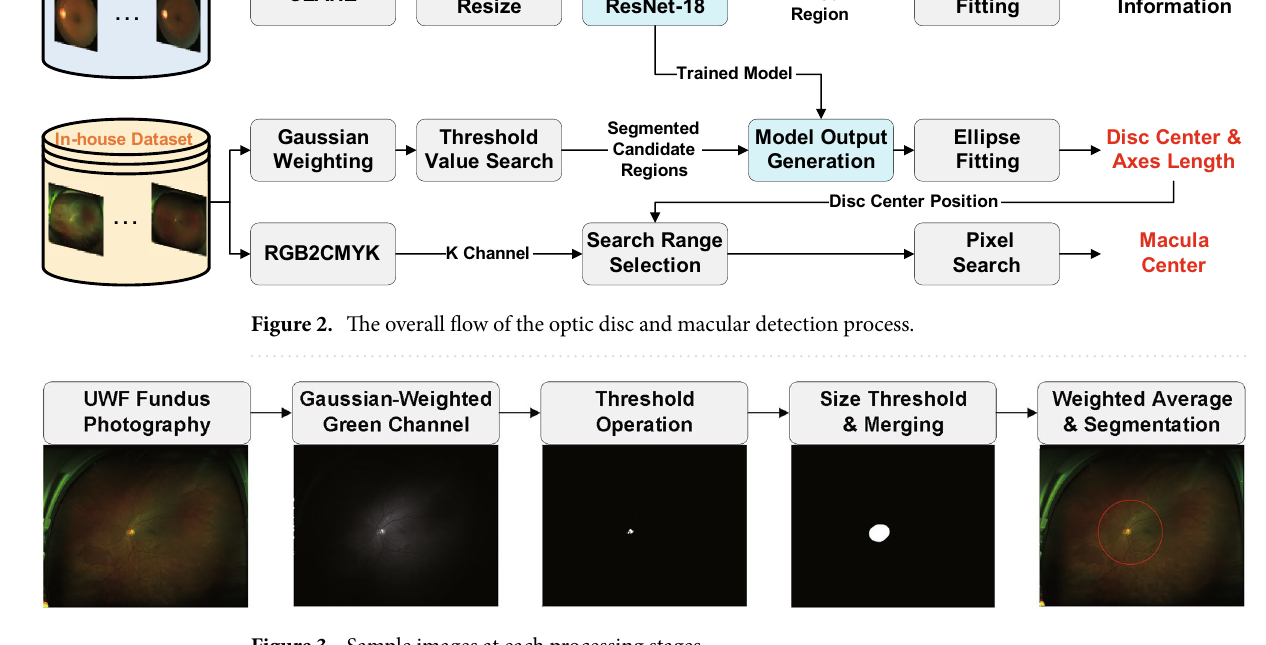
Figure 3. Sample images at each processing